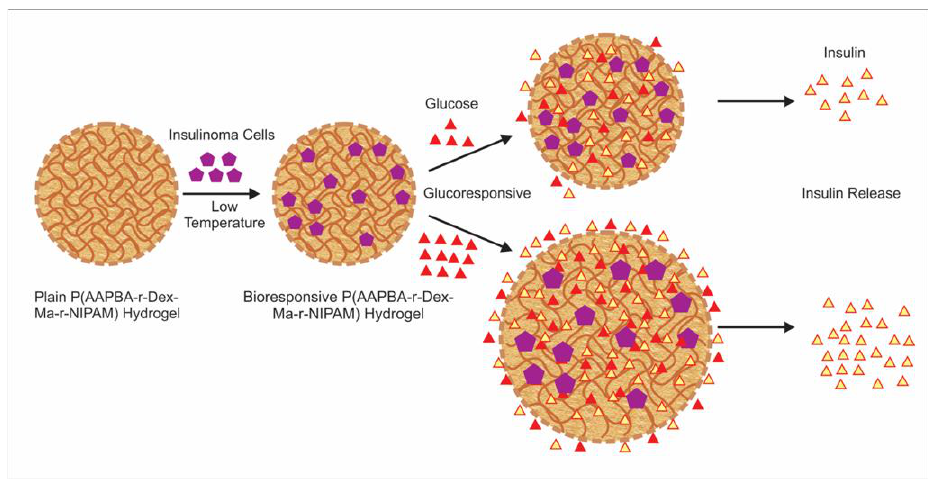
Figure 1. Schematic representation of the synthesis of poly( N -isopropylacrylamide- co -dextran-maleic acid- co -3-acrylamidophenylboronic acid) hydrogel, insulin-secreting cell encapsulation, and insulin release under glucose conditions.